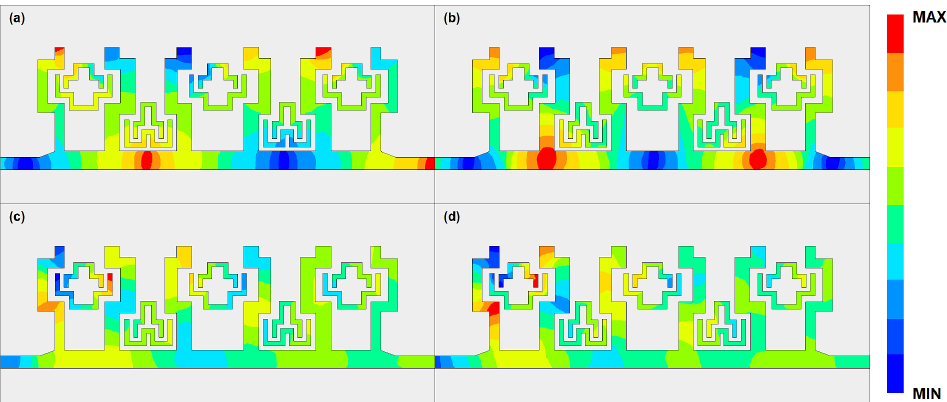
Figure 17. Schematic diagram of the field distribution of the proposed SSPP-SL-CSRR structure at ( a ) 54.3 GHz, ( b ) 63.2 GHz, ( c ) 59.0 GHz, and ( d ) 61.5 GHz. ( a ) 54.3 GHz, ( b ) 63.2 GHz, ( c ) 59.0 GHz, and ( d ) 61.5